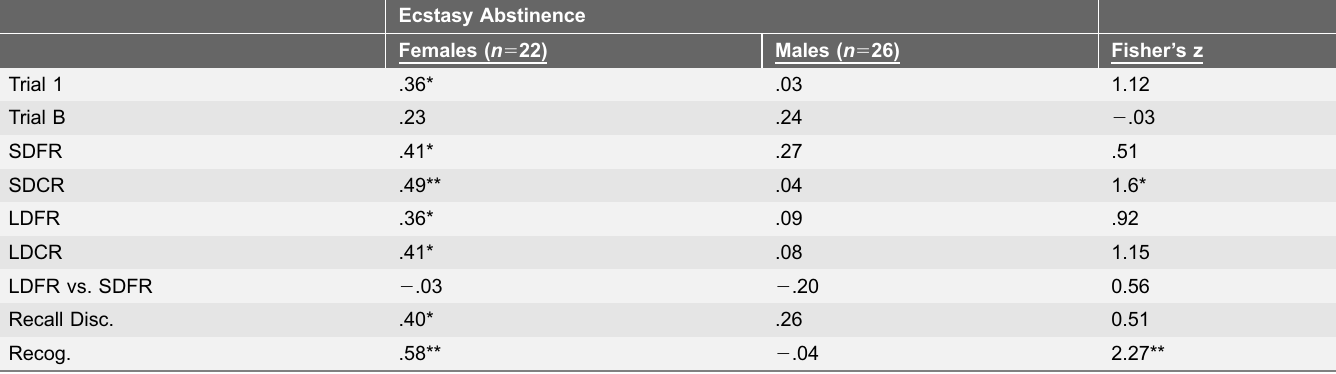
Table 5. Simple Relationships between Components of Verbal Memory and Ecstasy Abstinence by